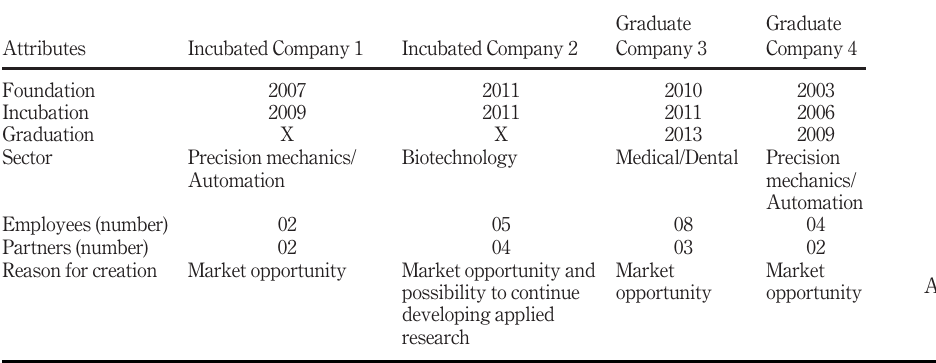
Table I. Attributes of